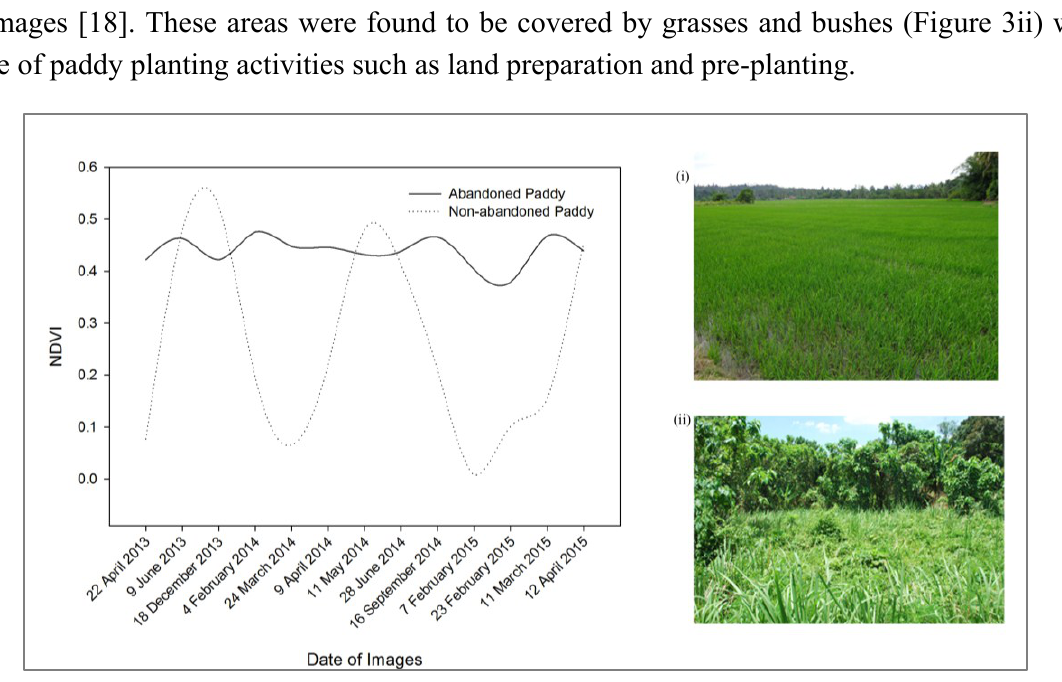
Figure 3. Phenology for paddy; ( i ) non-abandoned paddy; ( ii ) abandoned